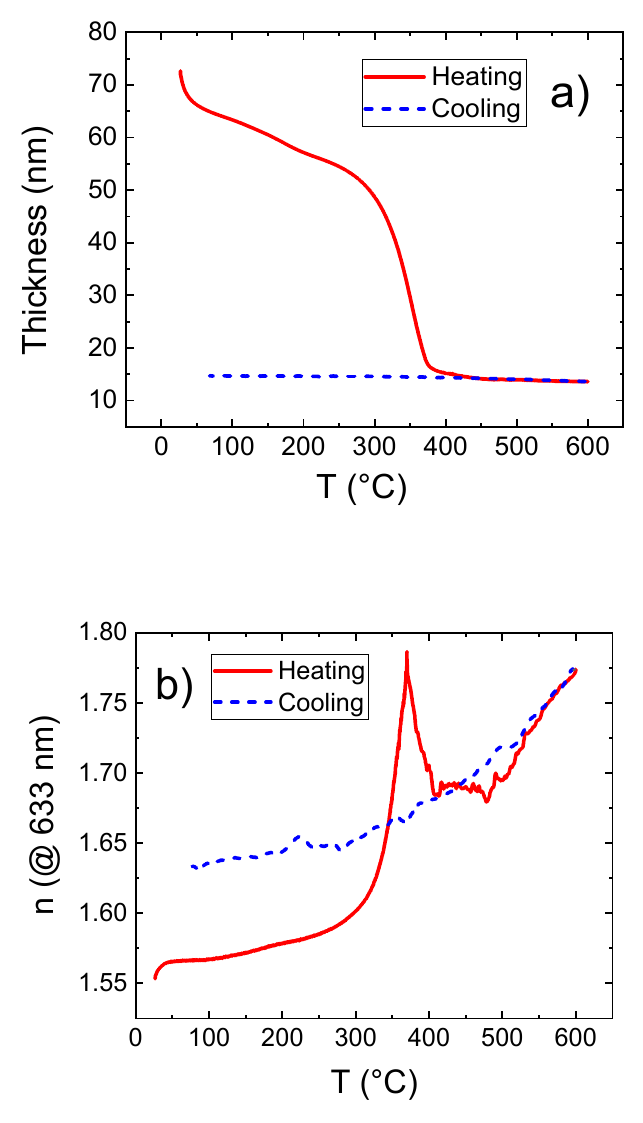
Figure 10. ( a ) Film thickness and ( b ) refractive index as a function of temperature measured during a heating cycle 25 °C–600 °C–25 °C on the zinc-organic film.